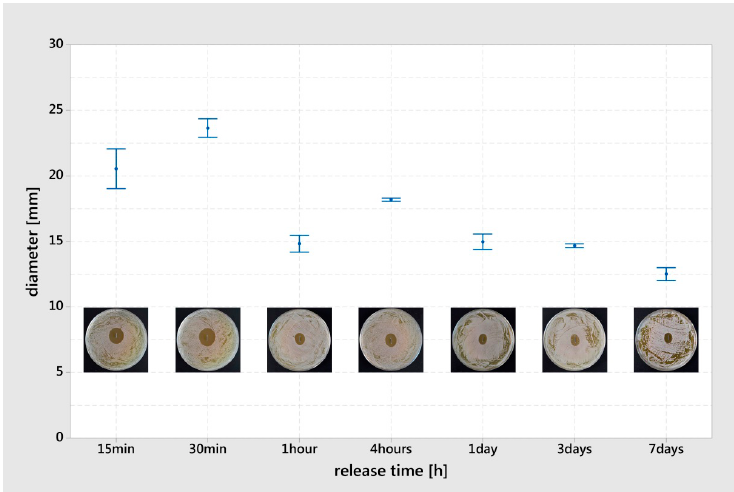
Figure 4. Zone of inhibition (ZOI) ( Staphylococcus cohnii ) generated from the G hybrid K-wire pieces after previous release in an agar medium. The results are displayed as mean values and standard errors (n = 3). A characteristic picture of the corresponding ZOI was integrated into the chart.